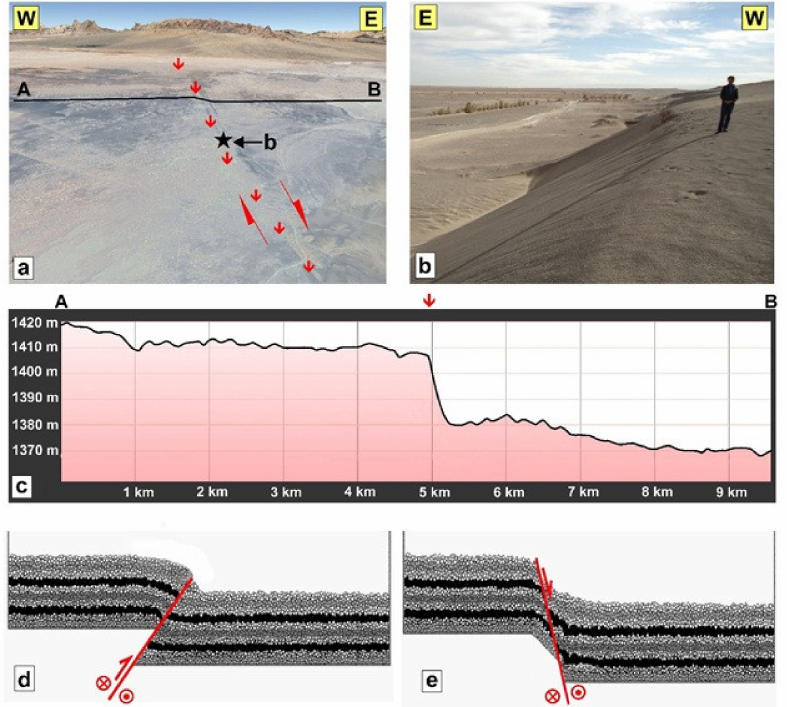
Figure 2. ( a ) The Anar fault trace in the south termination. ( b ) Field image of the Anar fault scarp. ( c ) Topographic cross-section perpendicular to the fault, which shows ~30 m of the scarp. ( d , e ) Two scenarios that could have created the Anar fault